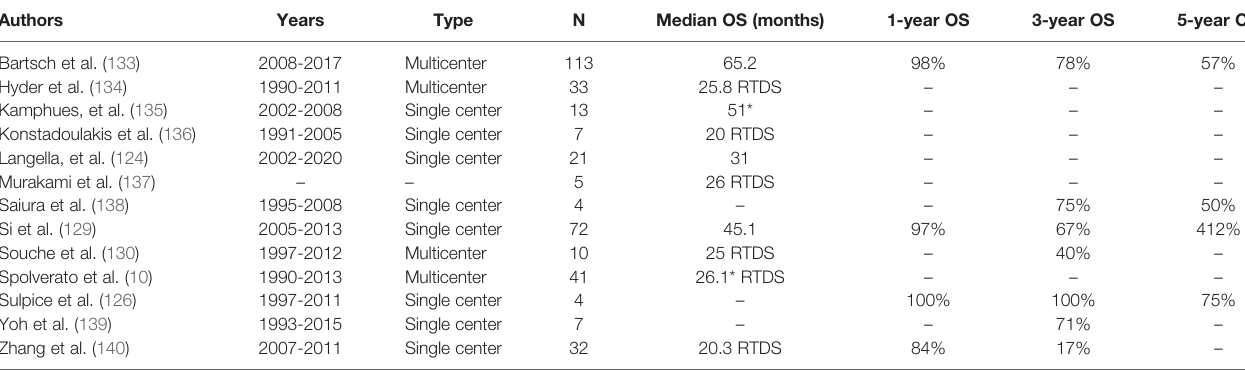
TABLE 3 | Survival after repeat resection for intrahepatic cholangiocarcinoma recurrence in the liver.